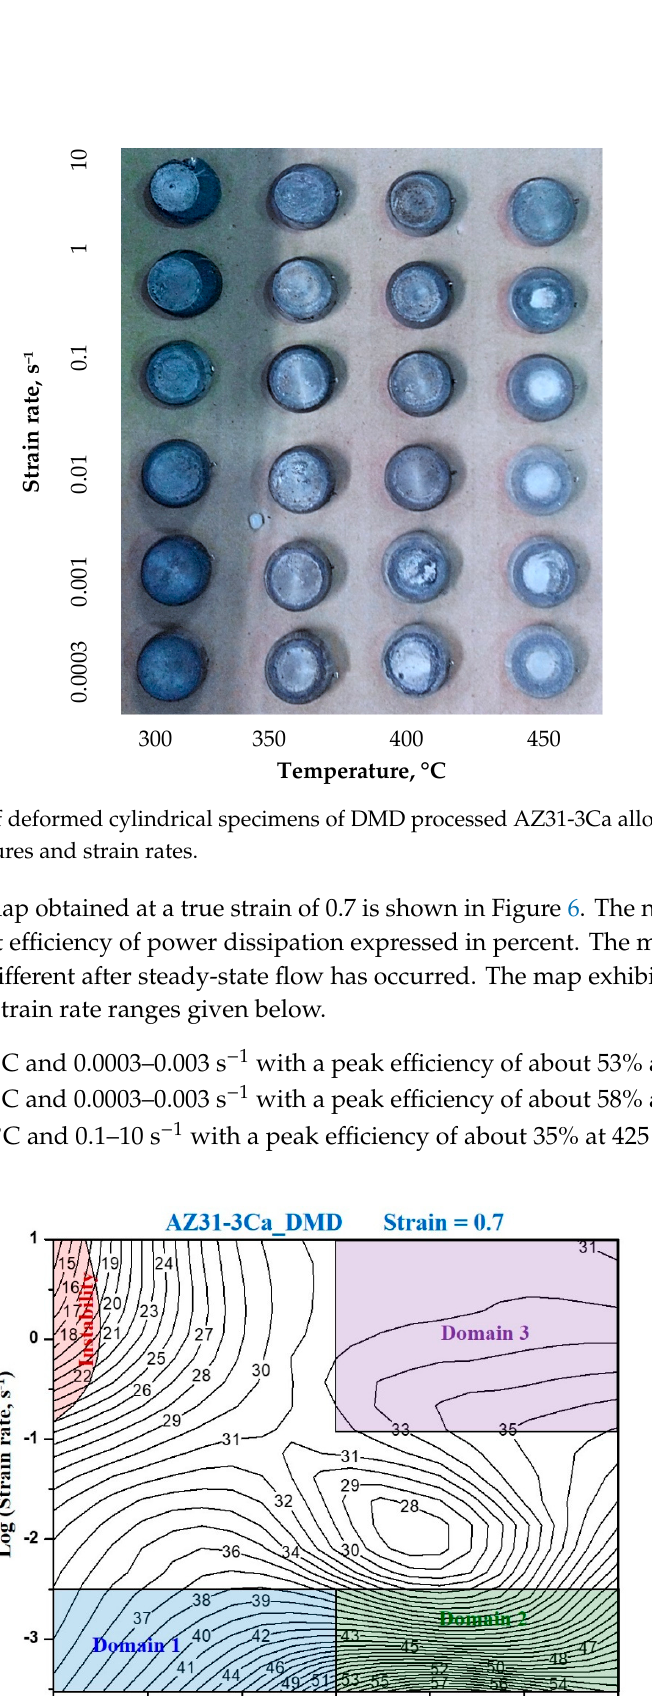
Figure 4. True stress–true strain curves obtained in compression on DMD processed AZ31-3Ca alloy at different strain rates at temperatures of ( a ) 300 ° C, and ( b ) 400 ° C.